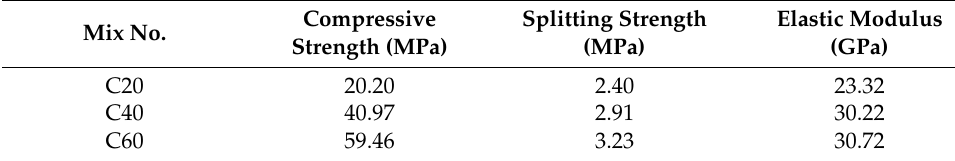
Table 6. Mechanical properties of the